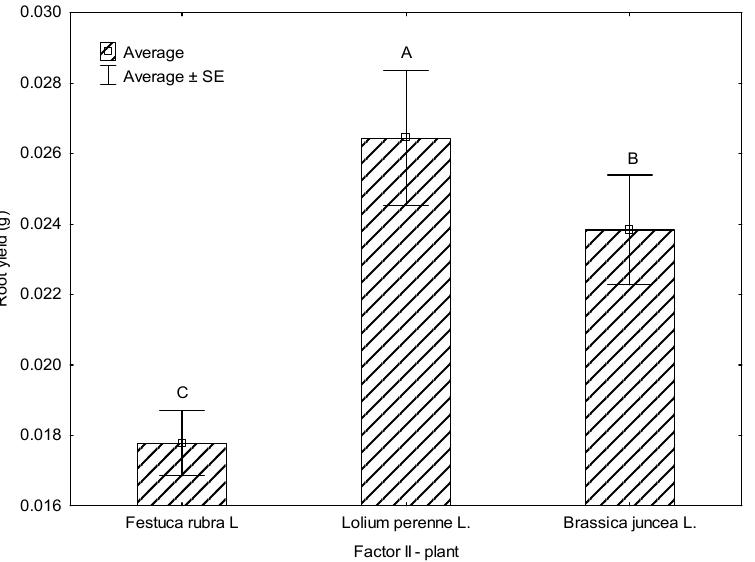
Figure 14. Root yield of Festuca rubra L., Lolium perenne L. and Brassica juncea L. from a pot experiment carried out for unburnt soil, burnt soil and burnt soil supplemented with different amendments. Average values (n = 18) ± SE are presented. Different letters indicate significant differences ( p <